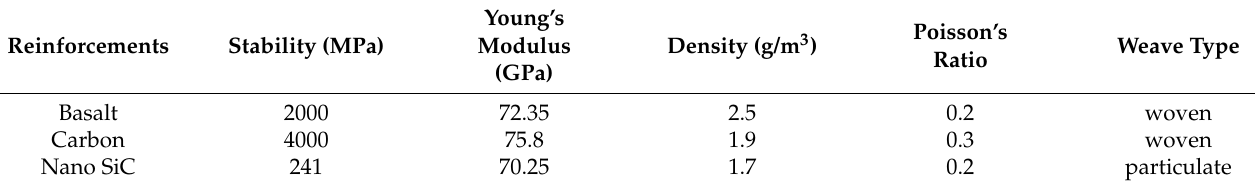
Table 1. The physical characteristics of